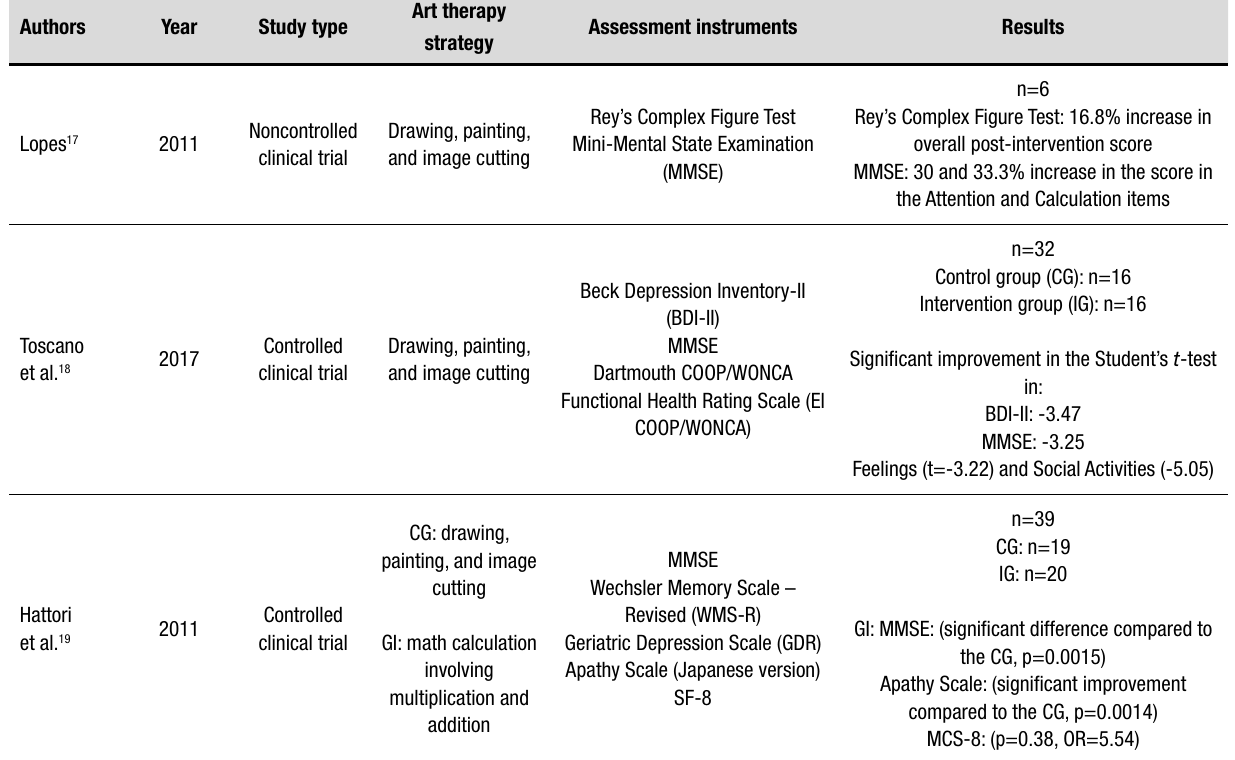
Table 2. Bibliographic sources identified, place of study, type of study, sample, evaluation protocol, intervention, and outcomes. Authors